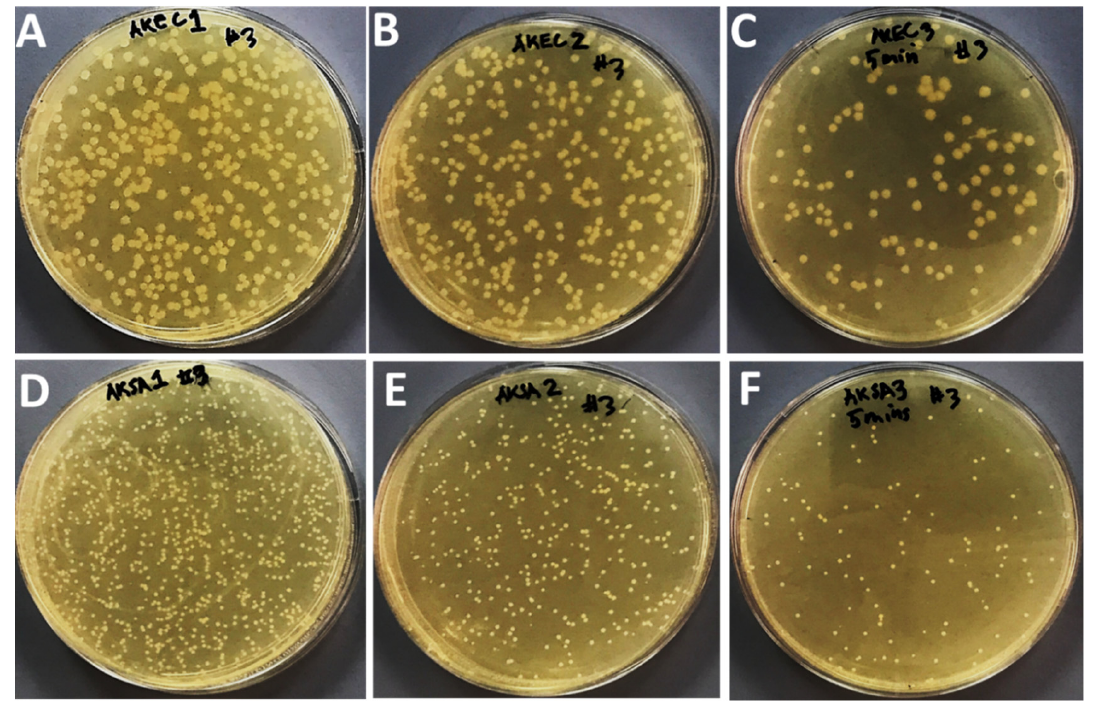
Figure 6. Effects of Se-Ag 3 PO 4 on the growth of E. coli ( A – C ) and S. aureus ( D – F ). ( A , D ); without compound and without sonication, ( B , E ) with compound but without sonication, and ( C , F ); with compound and 5 min of sonication.